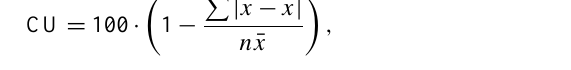
Figure 5. Data and regression for bucket volume as a function of tipping